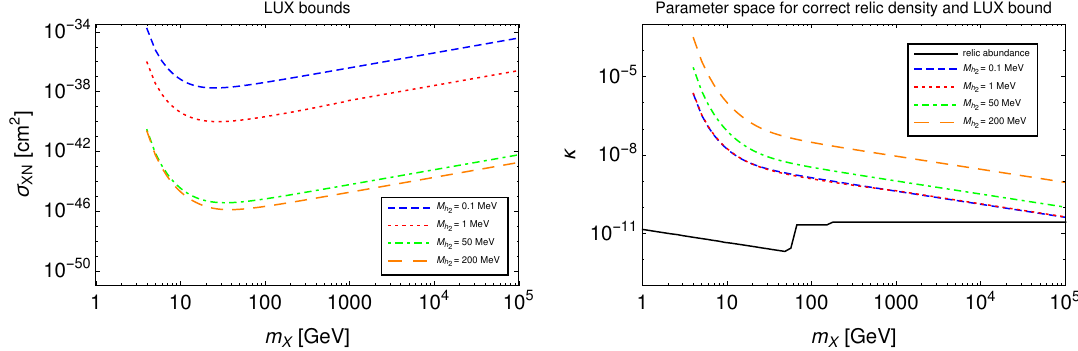
Figure 5 . LUX upper bounds on the total SI VDM nuclear recoil cross section (cid:27) XN (left panel) and Higgs portal coupling (cid:20) (right panel) for di(cid:11)erent light mediator h 2 masses. The solid black curve in the right panel corresponds to parameters which reproduce the measured value of the DM relic